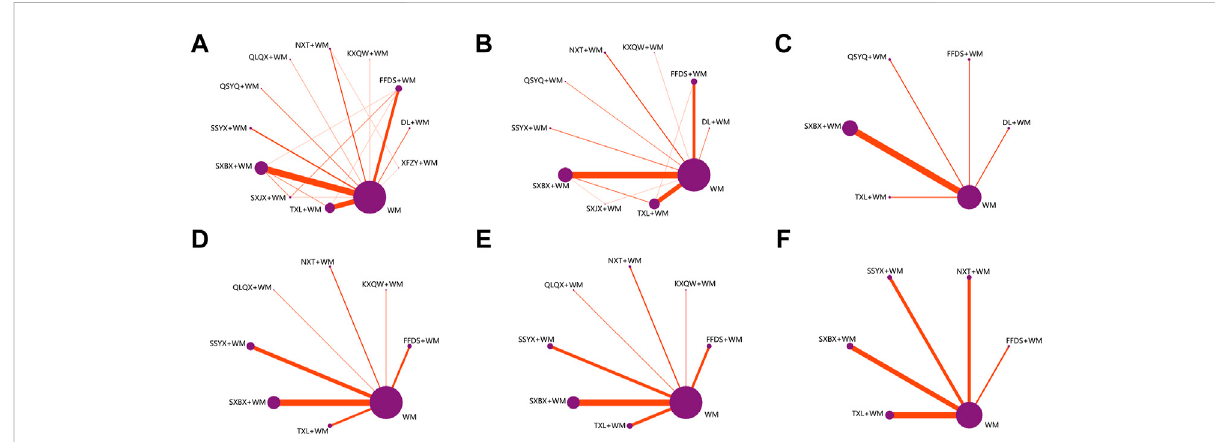
FIGURE 2 Network graph for different outcomes (A) Clinical effective rate; (B) Effective rate in ECG; (C) Cardiovascular events rate; (D) Weekly frequency of angina; (E) Duration of an angina attack; (F) Weekly nitroglycerin usage; WM, Western medicine; FFDS, Fufang Danshen dripping pill; DL, Danlou tablet; KXQW, Kuanxiong aerosol; NXT, Naoxintong capsule; QLQX, Qiliqiangxin capsule; QSYQ, Qishen Yiqi dripping pill; SSYX, Shensong Yangxin capsule; SXBX, Shexiang Baoxin pill; SXJX, Suxiao Jiuxin pill; TXL, Tongxinluo capsule; XFZY, Xuefu Zhuyu